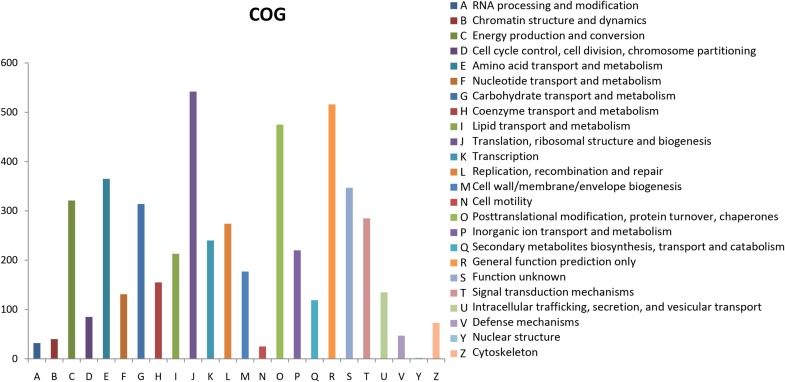
COG functional classification of the C. chago transcriptome.